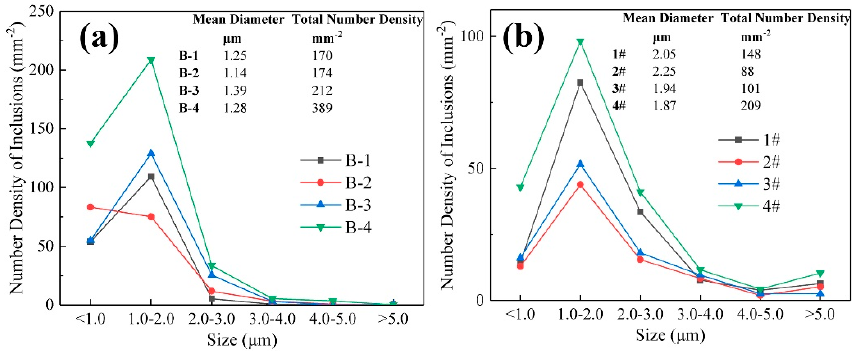
Figure 7. Size distribution of inclusions in the ( a ) melts and ( b ) as-cast samples.